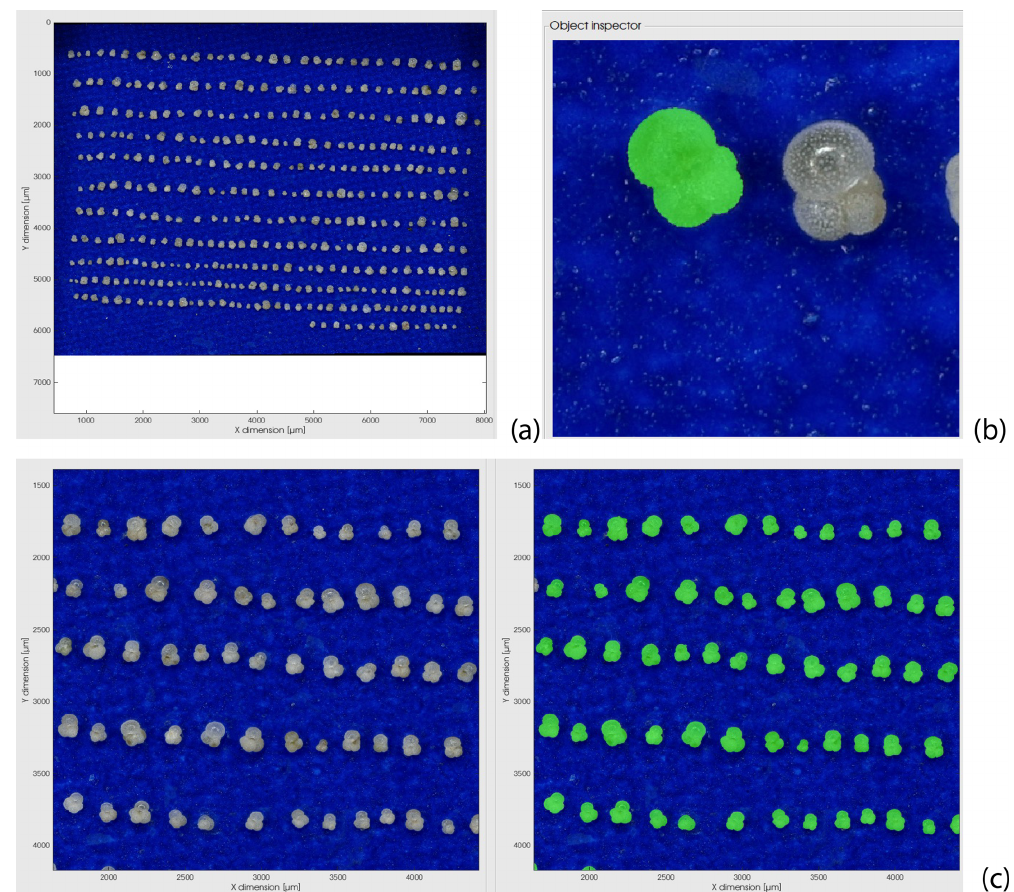
Figure A1. Example of the segmentation procedure used for the planktonic foraminifera size measurement based on tri-dimensional images generated by a Keyence digital microscope (see Sect. 2.2). (a) Keyence image of Globigerinita glutinata specimens positioned in umbilical view for a primary size segmentation based on particle elevation; (b) second and final size segmentation (in green) of the specimens based on an implementation of the sparse field method on the RGB data (see Sect. 2.2); at this step, the quality of each specimen size segmentation can be checked; (c) example of the full segmentation results on a magnified area of panel (a) with the original picture (left) and all specimens segmented in green